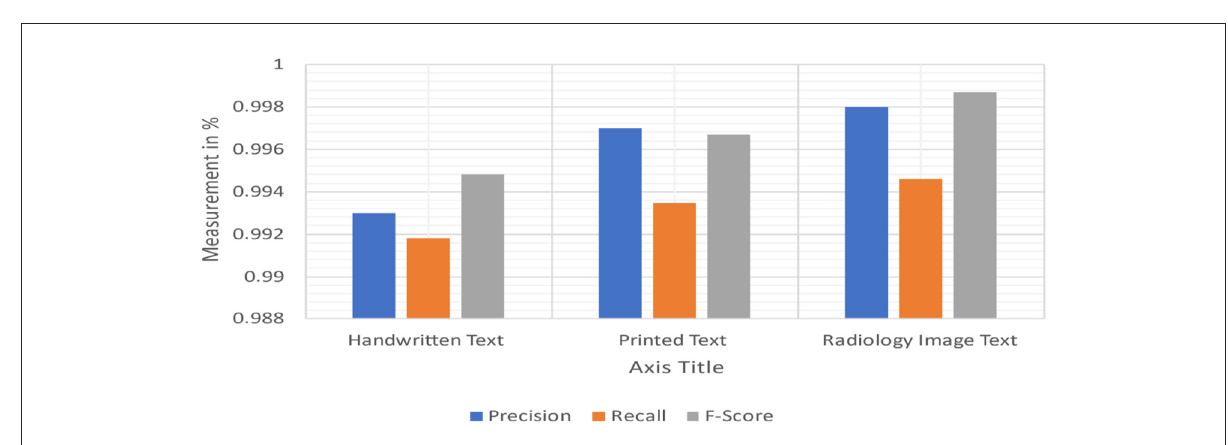
FIGURE15 Measuring recall, precision, and